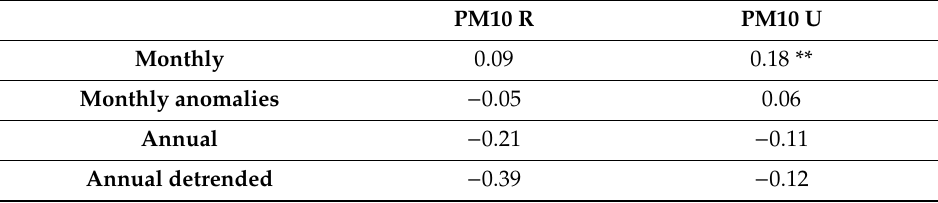
Annual detrended − 0.12 ** indicate statistical significance at the 99%